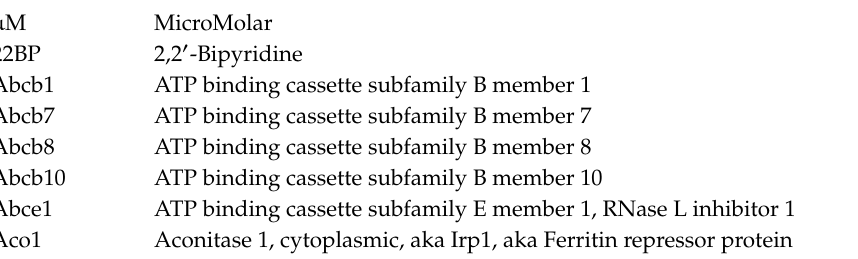
Table S1, Perseus software output of global proteome analyses; Table S2, Statisctical details of transcriptional changes; Figure S1, Dysregulations in global proteome of WT MEF after FAC-treatment; Figure S2, Volcano plots of global proteome profiles; Figure S3, STRING diagram of consistently dysregulated factors; Figure S4, Dysregulations in global proteome of WT MEF after 22BP-treatment; Figure S5, Transcriptional dysregulations upon RT-qPCR analyses; Figure S6, Transcriptional dysregulations of antioxidant and hypoxic